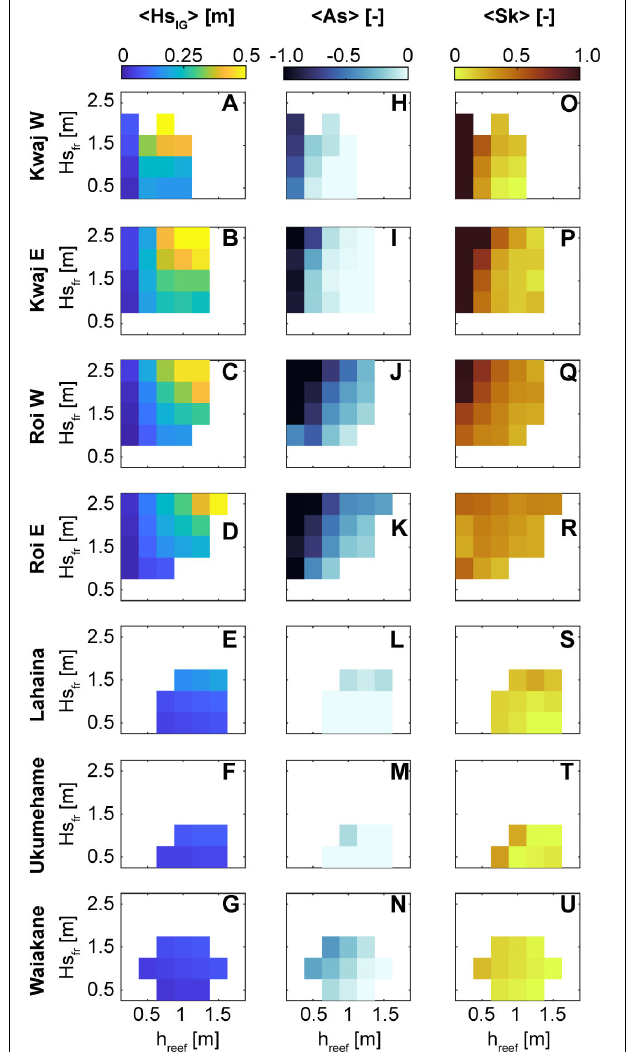
FIGURE 4 | Mean height ( Hs IG ), asymmetry ( As ), and skewness ( Sk ) of inner reef-flat infragravity (IG) waves with different reef submergence ( h reef ) and fore-reef wave heights ( Hs fr ). Each row is a different site. Values are only displayed if there were at least 10 water level bursts for the given h reef and Hs fr levels. (A–G) Mean IG wave heights. (H–N) Mean asymmetry of the IG waves; darker blue indicate more steep-faced, bore-like waves. (O–U) Mean skewness of the IG waves; darker reds indicate more peaked waves. Lower reef flat submergence and larger offshore waves generally produce the most negatively asymmetrical (pitched onshore) and positively skewed IG waves in the inner reef